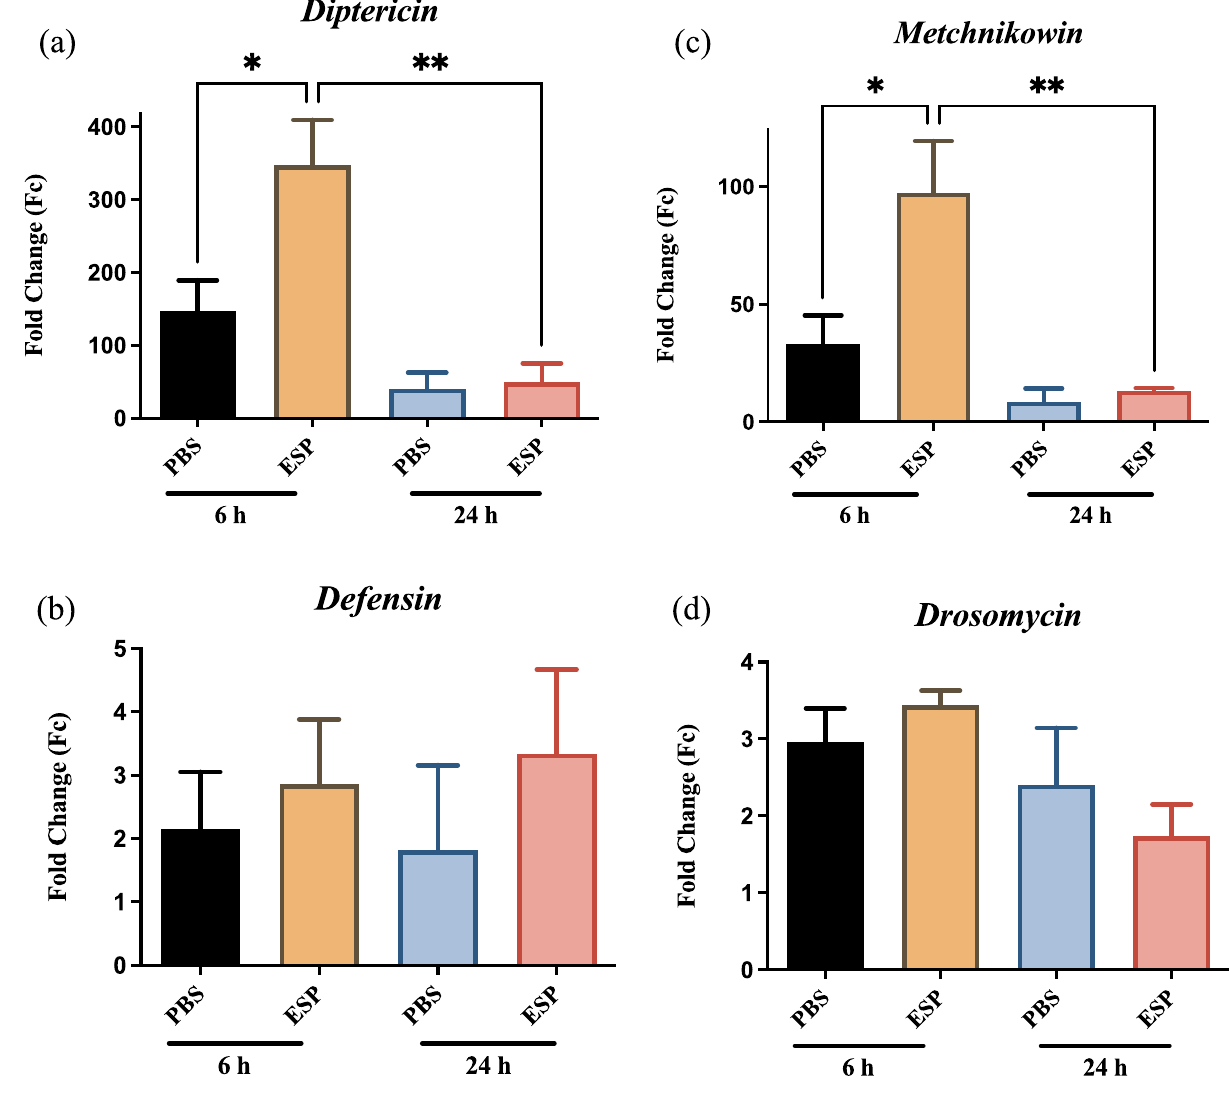
Figure 2. Antimicrobial peptide gene expression in Drosophila melanogaster injected with Steinernema carpocapsae nematode excreted/secreted products (ESPs). Oregon-R adult flies were injected with 3 ng of ESPs from S. carpocapsae nematodes or PBS as a control. Samples were collected at 6 and 24 h and following quantitative RT-PCR, mRNA values were normalized to a baseline 0-h time point and the housekeeping gene RpL32. Expression of ( a ) Diptericin , ( b ) Defensin , ( c ) Metchnikowin , and ( d ) Drosomycin (* P < 0.01, ** P < 0.001; One-way